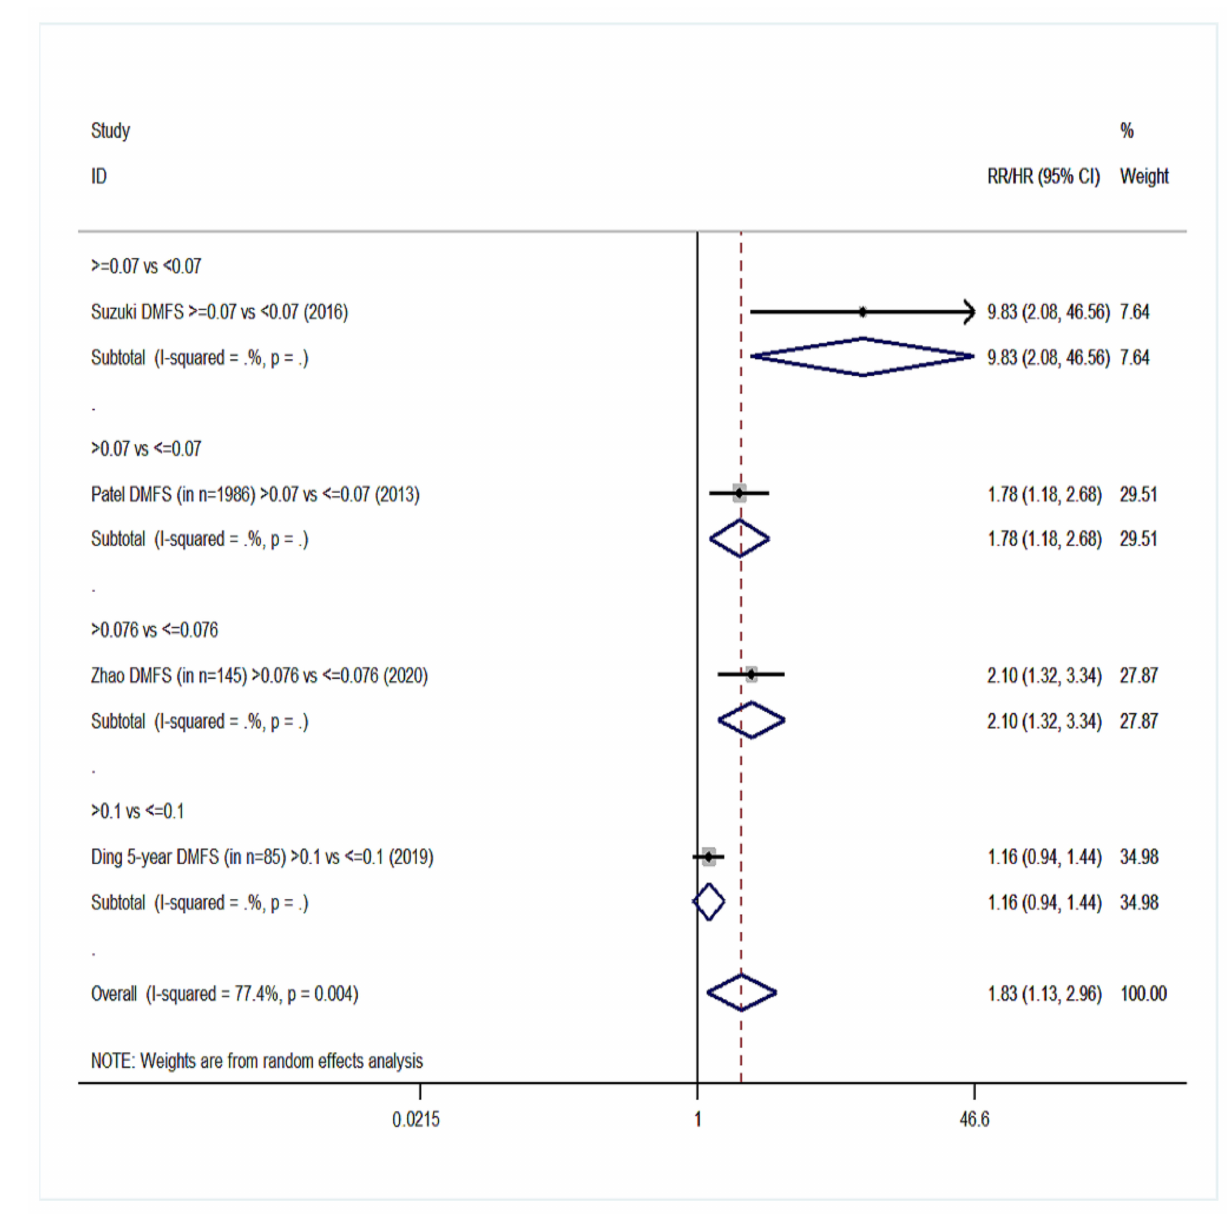
Figure 6. Forest plot demonstrating associations between lymph node ratio (LNR) and distant metastasis-free survival (DMFS) in group YES. Apart from the overall analysis, the subanalyses by LNR cut-off values are